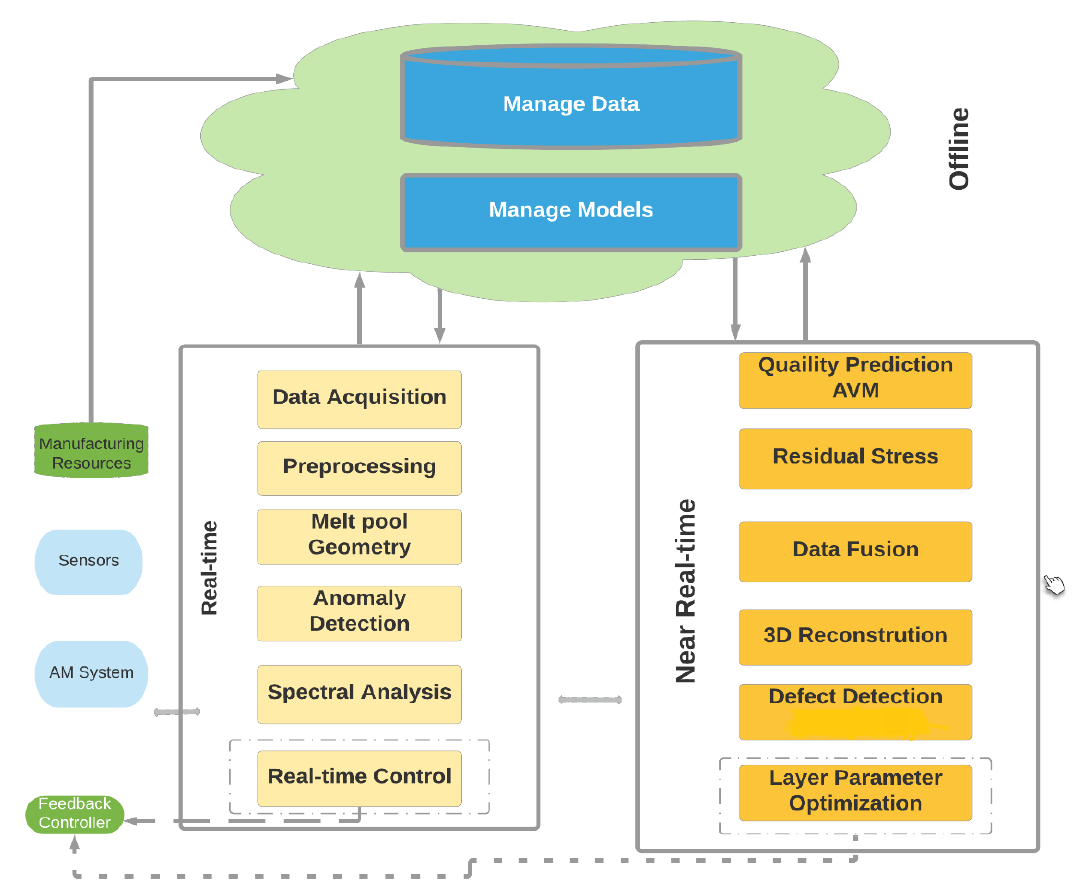
Figure 2. Integrated functional models.